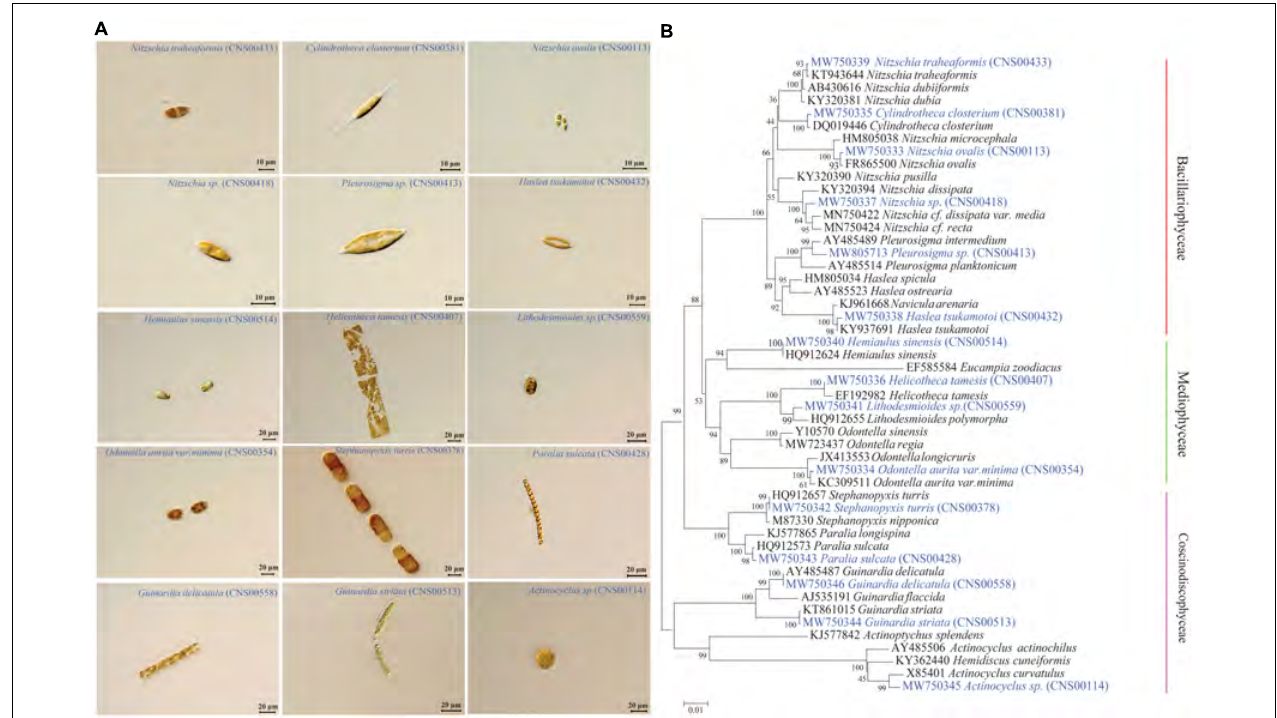
FIGURE 2 | Morphological and molecular anlaysis of diatom species analyzed in this study. (A) Representative micrographs of 15 diatom species studied in this project. (B) Phylogenetic analysis based on 18S ribosomal DNA (18S rDNA) gene. Numbers at the branches represent bootstrap values. Branch lengths are proportional to the genetic distances, which are indicated by the scale